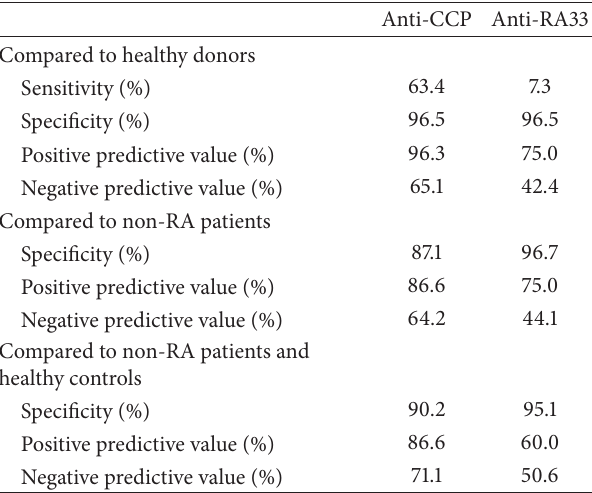
Table 3: Predictive value, specificity, and sensitivity of the anti-CCP and anti-RA33 tests in RA diagnosis.